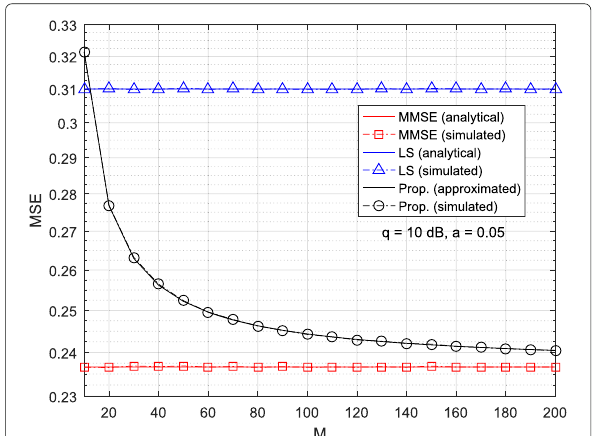
Fig. 4 MSE performance versus number of BS collocated antennas, M